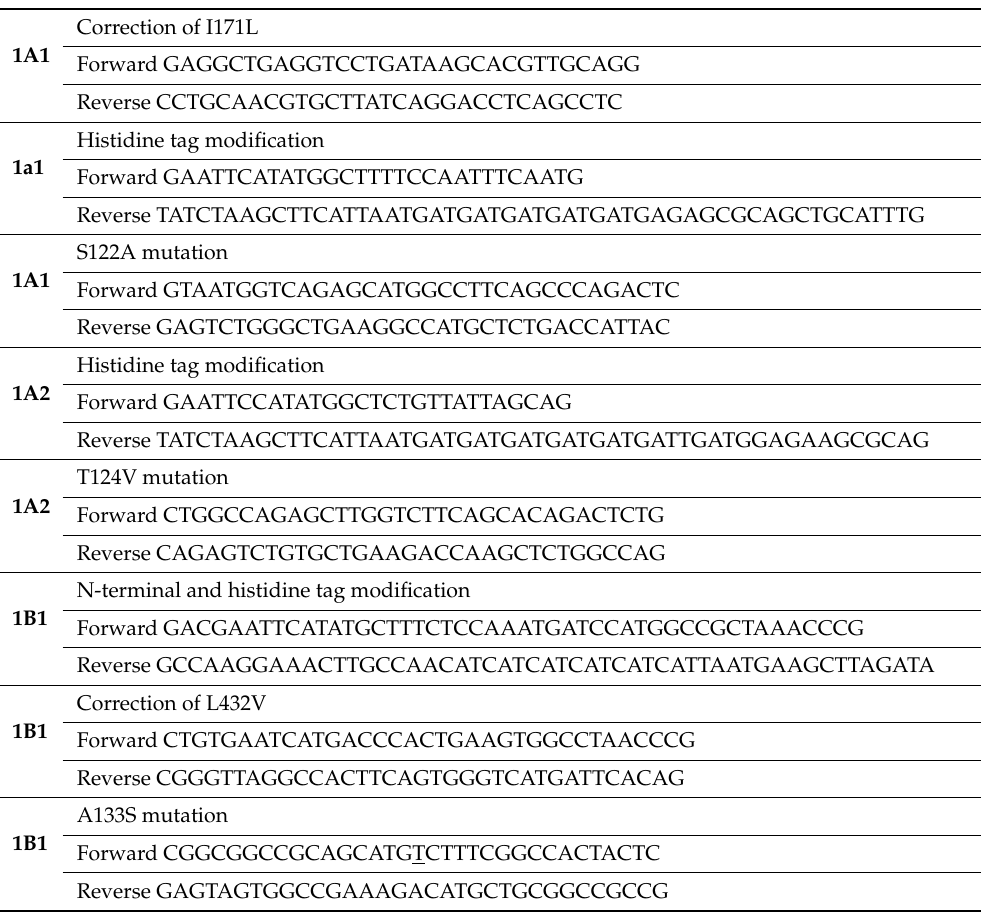
Table 3. Primers used for CYP gene